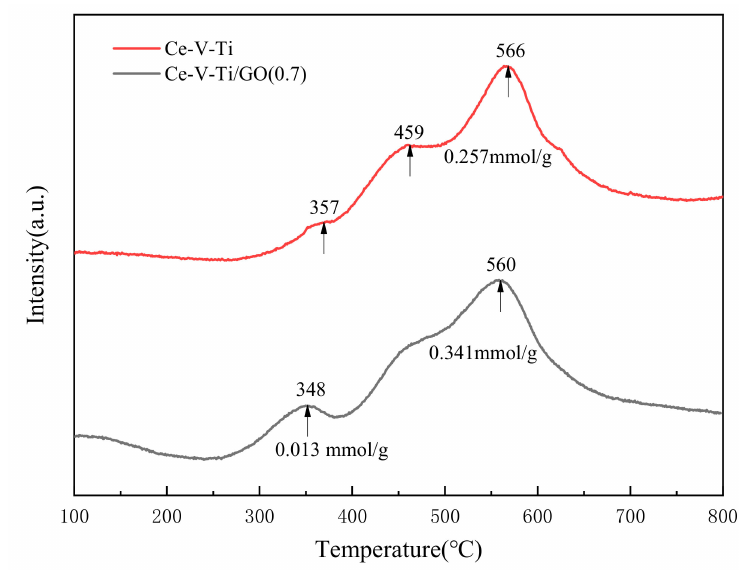
Figure 10. Temperature-programmed reduction (H 2 -TPR) profiles of the Ce-V-Ti and Ce-V-Ti / GO